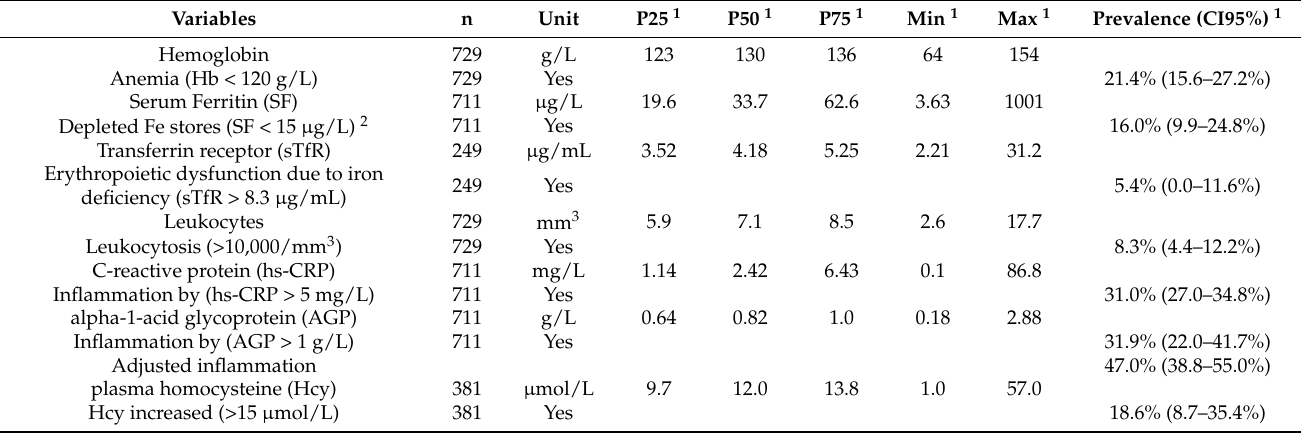
Table 2. Biomarkers and prevalence of anemia, iron deficiency, and inflammation in women of childbearing age, Cuba